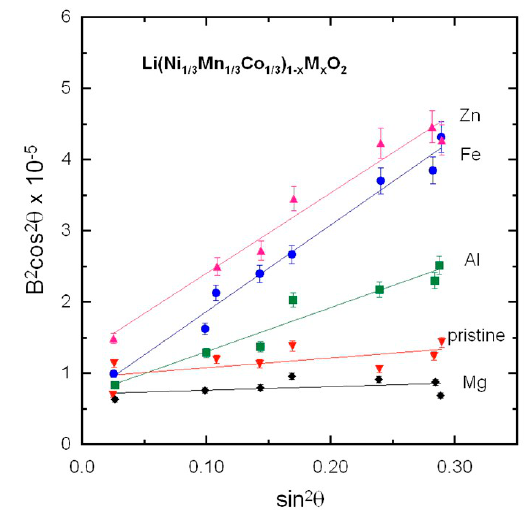
Figure 2. Analysis of the full-width at half-maximum, B , of XRD peaks according to Equation (1). B is expressed in radian.